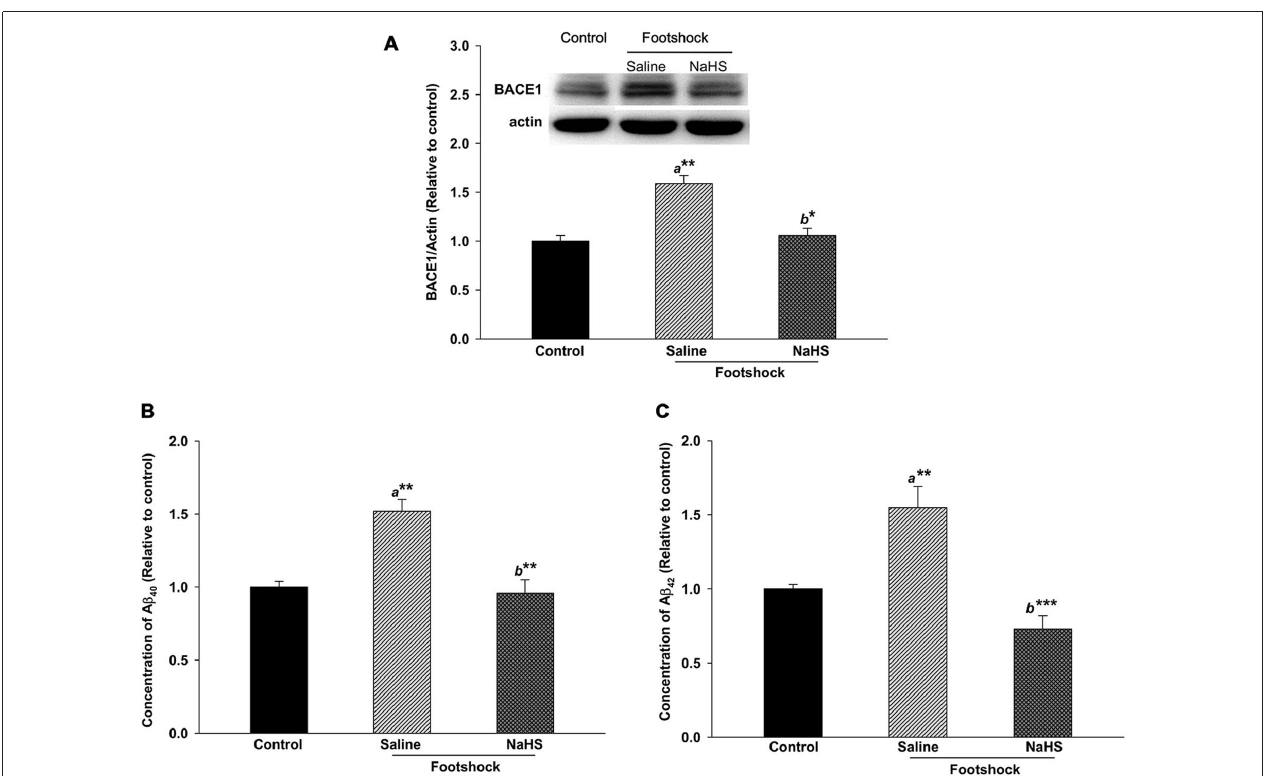
FIGURE 6 | NaHS treatment decreased the levels of A β and BACE1 in the hippocampi of mice under footshock stimulus. (A) Representative Western blot and densitometry for BACE1 in the mouse hippocampus. β -Actin was used as the internal control. (B) A β 40 levels in the mouse hippocampus analyzed by ELISA. (C) A β 42 levels in the mouse hippocampus measured by ELISA. The data are the mean ± SEM of each group ( n = 3–5 per group). ∗ p < 0.05; ∗∗ p < 0.01; ∗∗∗ p < 0.001. a , compared to the control group. b , compared to the footshock/saline group.